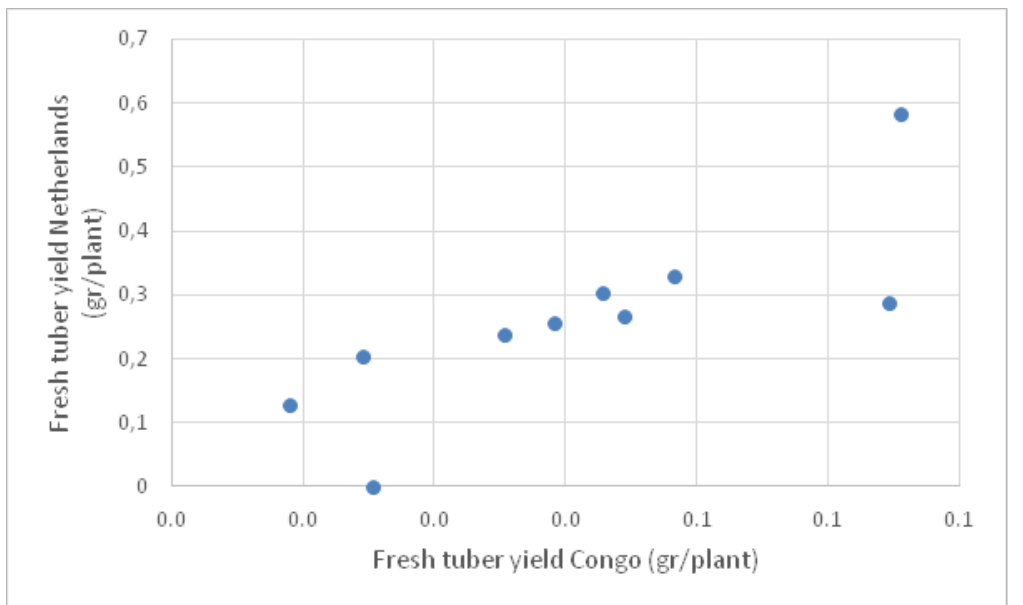
Fig 3. Correlation between the yield in gram/plant of ten diploid experimental potato hybrids in Congo DR compared to The